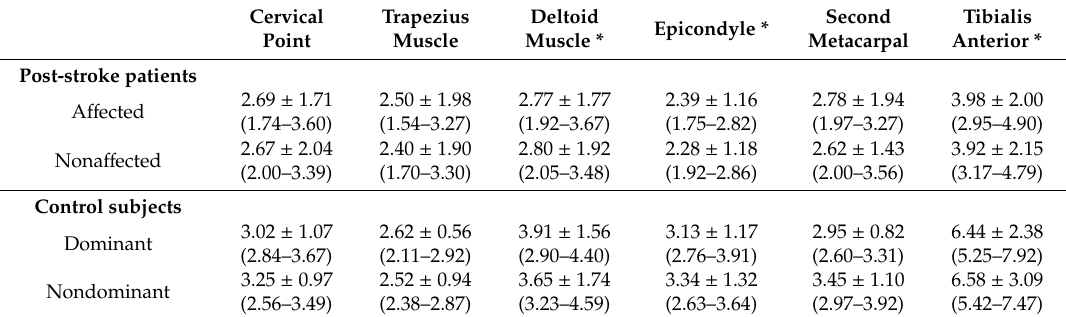
Table 2. Pressure pain thresholds (kg/cm 2 ) in post-stroke patients and healthy controls.